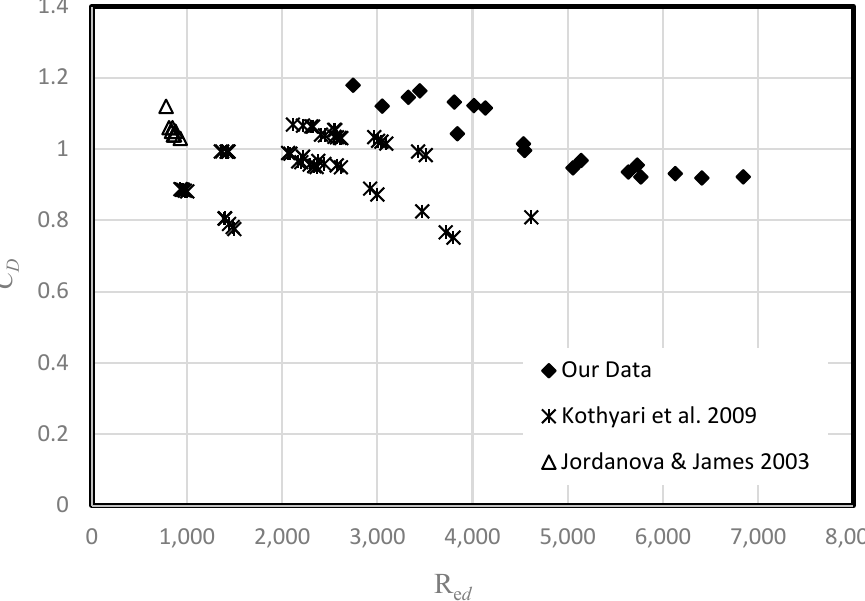
Figure 11. C D versus vegetation stem Reynolds number [11, 12].